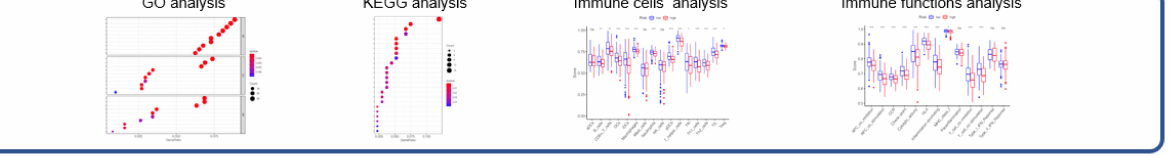
FIGURE 1 | The overall design and technical roadmap of the study.